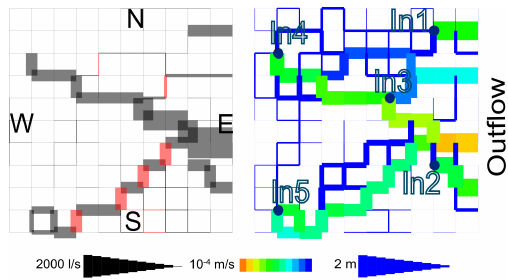
Figure 15. Quasi-stable state of network with same structure as pre- sented in Fig. 11, but the plane of the network is additionally tilted from N–S, for 0.3m per node.